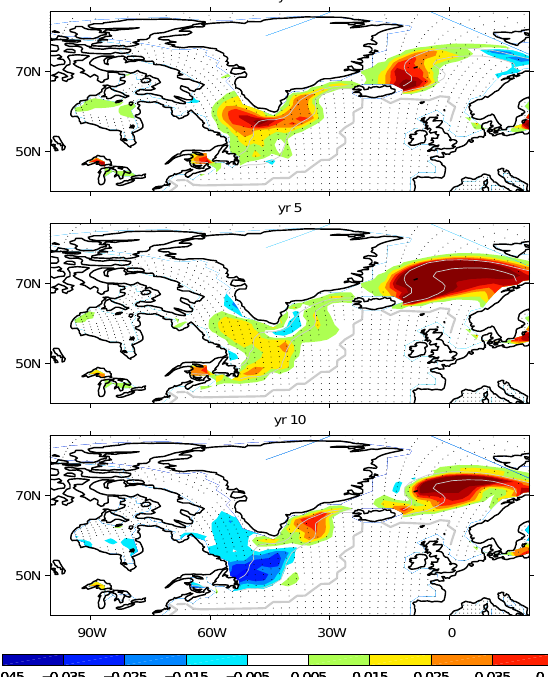
Fig. 18. Composites of anomalous March sea ice cover in response to volcanic eruptions occurring during the period 1100–1300. The composite is shown for the year following the eruption (left), 5 years later (middle), and 10 years later (right). Grey lines show contours of the average sea ice cover in March of 0, 0.5 and 1. Dotted areas are not significant at the 5%